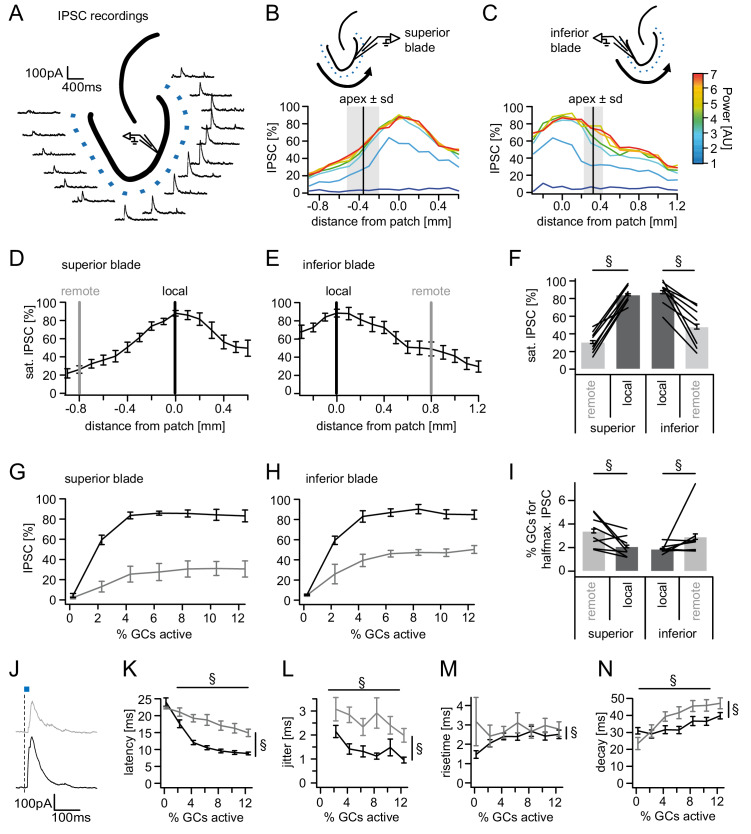
Spatial organization of feedback inhibition.Feedback IPSCs recorded from an individual GC while GCs at varying distances were activated. (A) Schematic illustration of the stimulation paradigm and example IPSC traces of an individual trial (p=3). (B, C) Distribution of normalized IPSC amplitudes as a function of laser power and distance from stimulation spot for superior and inferior blade GCs (n = 8 for each blade). The relative location of the DG apex ± standard deviation is indicated by the black bar and grey area respectively. (D, E) IPSC distribution over space at saturation (p≥5). Black and grey bars indicate a local and a remote location at 800 µm from the recorded cell respectively. (F) Comparison of the amplitude of the locally and remotely activated IPSCs at saturation (two-way RM ANOVA, overall test significance indicated by §). (G, H) Comparison of the recruitment curves during local (black) or remote (grey) stimulation for superior and inferior blade respectively. (I) Comparison of the cell fraction required for halfmaximal IPSC activation between stimulation sites and blades (two-way RM ANOVA overall test significance indicated by §). (J–M) Temporal properties of IPSCs between local (black) and remote (grey) stimulation. To test for systematic variations of kinetic parameters with increasing active cell fractions as well as stimulation site two-way RM ANOVAs with no post tests were performed. Overall significance indicated by §. (K) Latency from beginning of light pulse to IPSC (L) temporal jitter of IPSCs (SD of latency within cells) (M) 20% to 80% rise time (N) IPSC decay time constant.